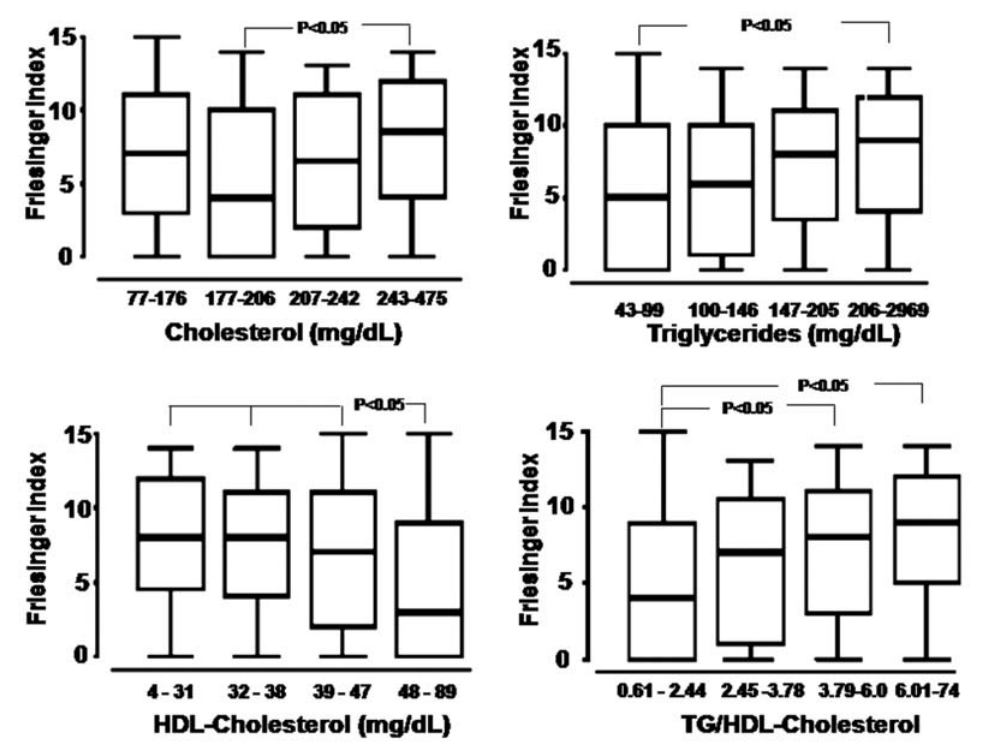
Figure 2 - Boxplot distribution of Friesinger index by quartiles of total cholesterol, triglycerides, HDL-cholesterol, and